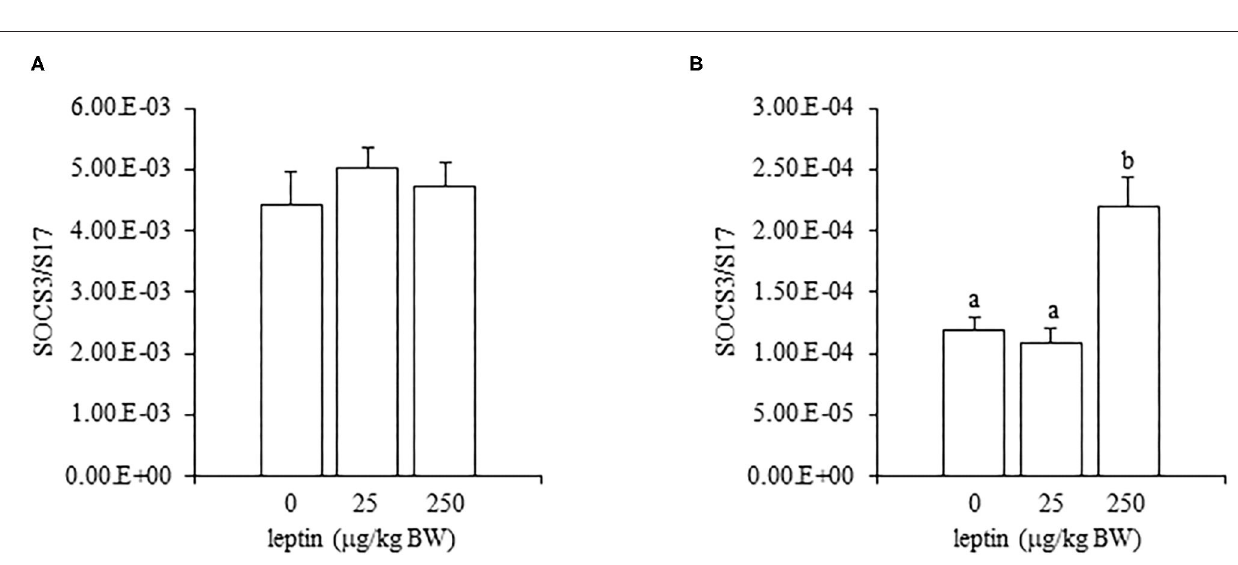
FIGURE 8 | The mRNA expression of SOCS3 in the ovary at 24h after leptin treatment in 7-day-old (A) and 28-day-old (B) chicks. Chicks were injected i.p. with 0, 25, and 250 µ g/kg BW of rmleptin. The data represent the mean ± SEM ( n = 4), and bars with different superscripts are significantly